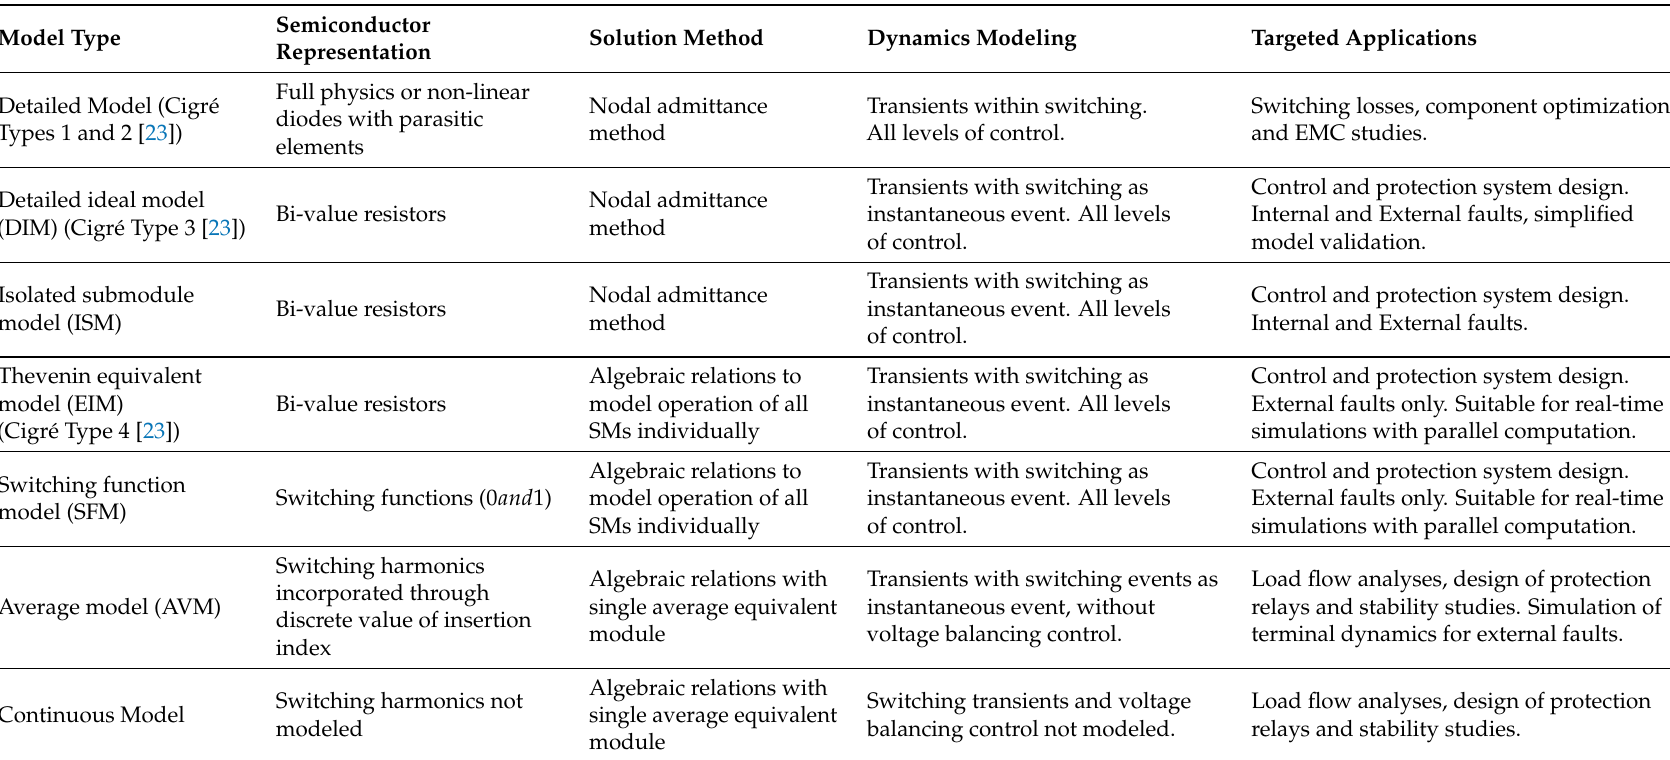
Table 4. EMT models for MMC: